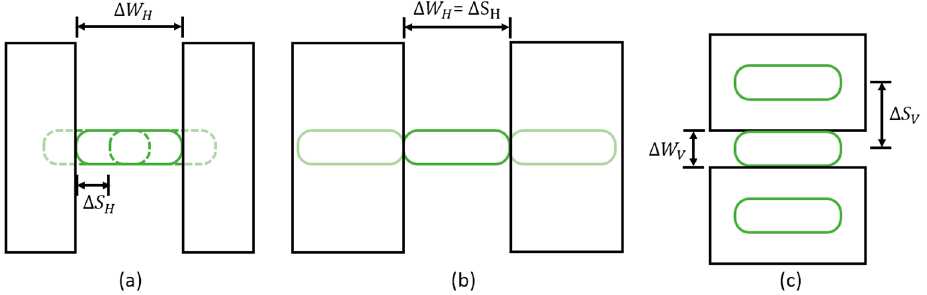
Figure 15. Configuration for the minimum resolvable angular separation for ( a ) the oversampled and ( b ) normal sampled cases in the horizontal direction and ( c ) the vertical direction.